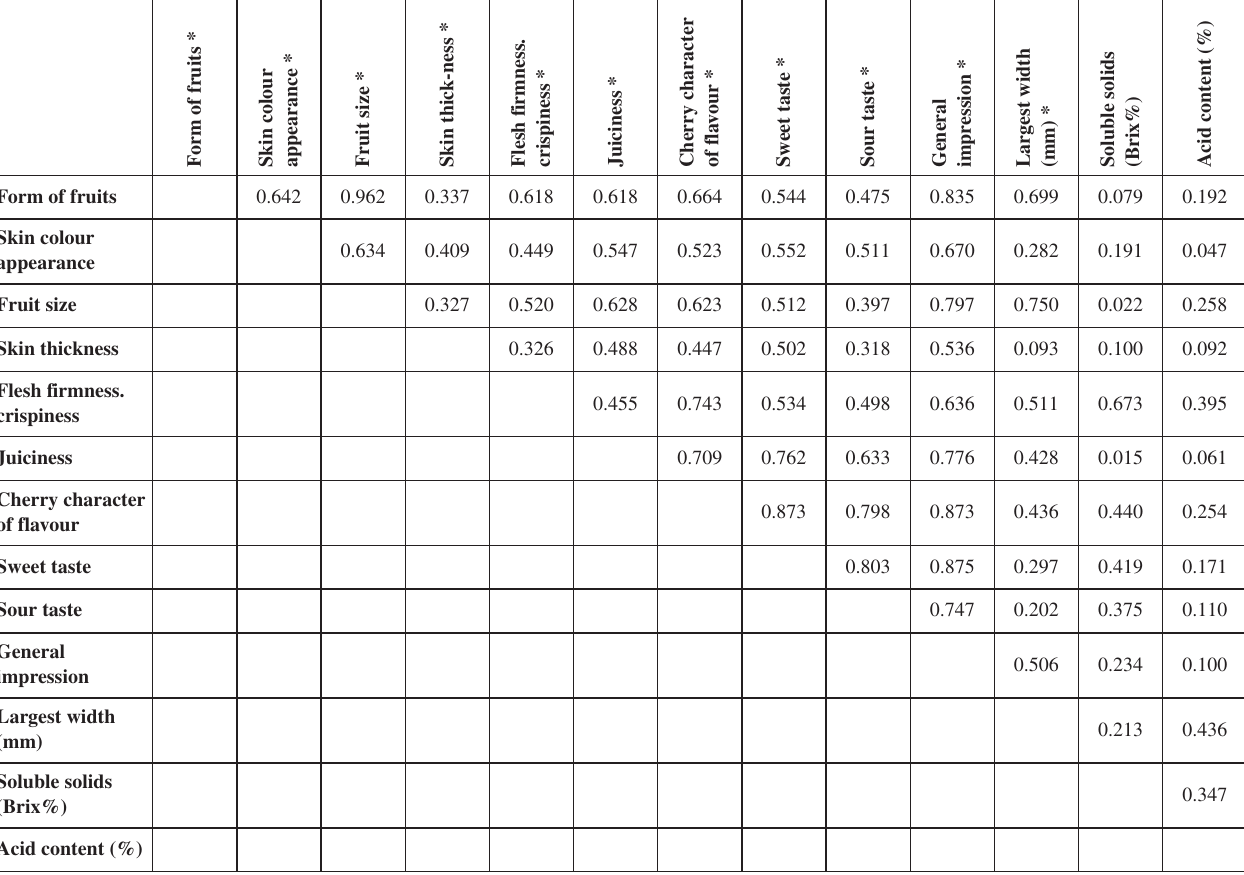
Table 6. A matrix of correlations between the parameters of sensorial judgment of properties rated in sweet cherry fruits (n=27)